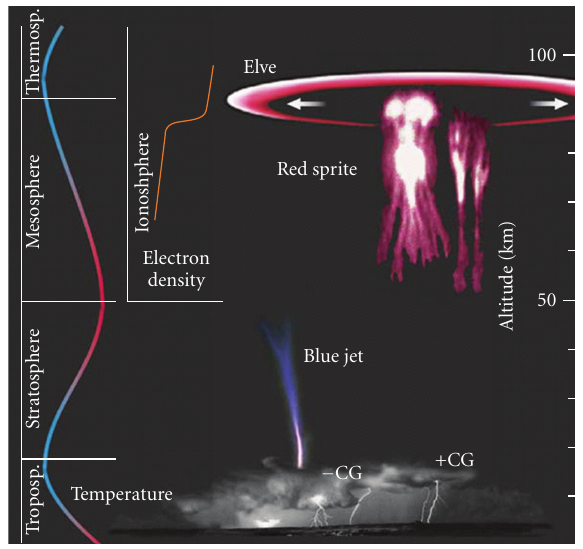
Figure 2: Depiction of various optical events in the atmosphere and the altitude at which they occur, credit